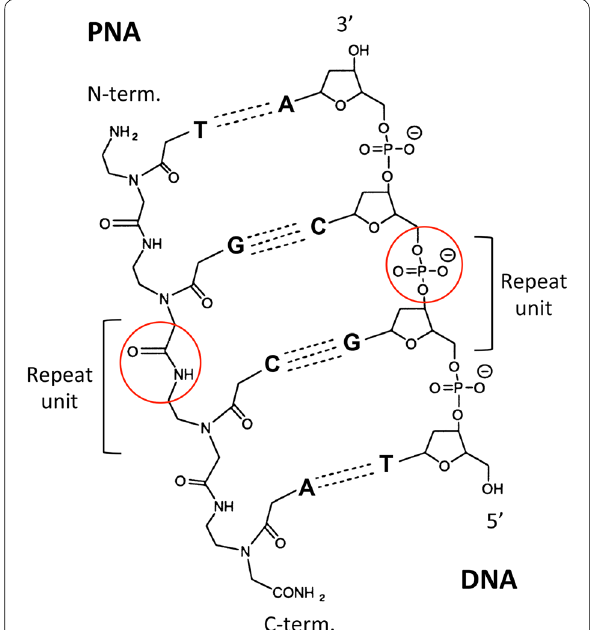
Fig. 25 Schematic chemical structures of PNA and DNA. The circles show the different backbone linkages of PNA and DNA. A, T, G, and C denote adenine, thymine, guanine and cytosine,